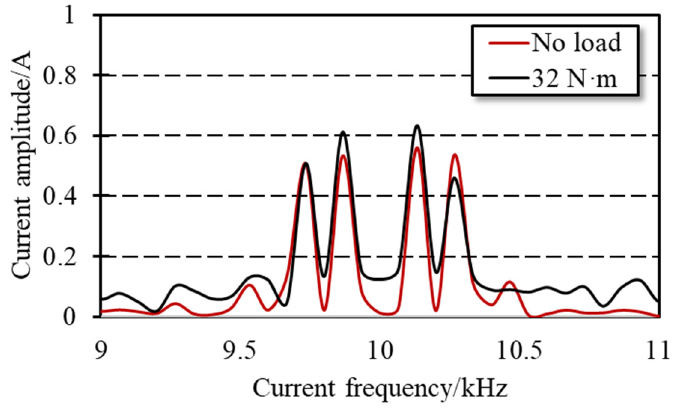
Figure 12. Sideband current at load and no